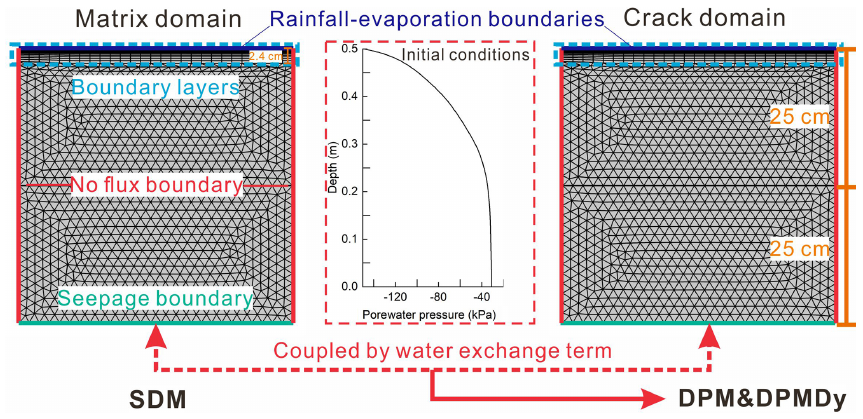
Figure 9. Setup of the 2-D numerical model for the SDM, DPM and